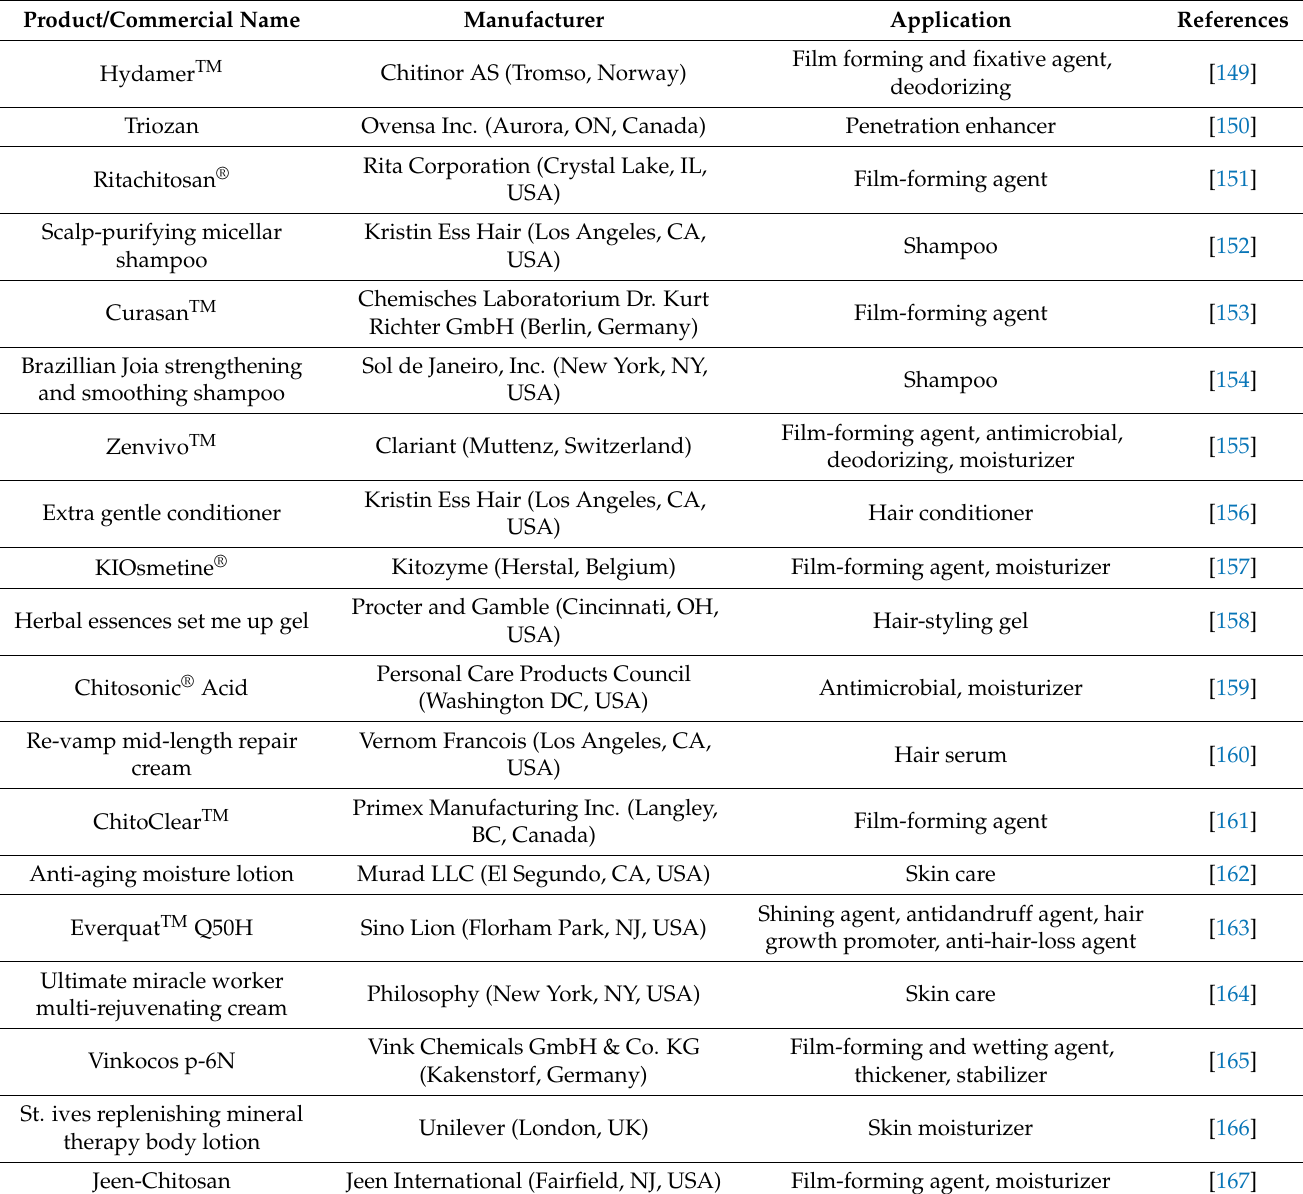
Table 3. Table 3. Commercially available chitosan included cosmetic